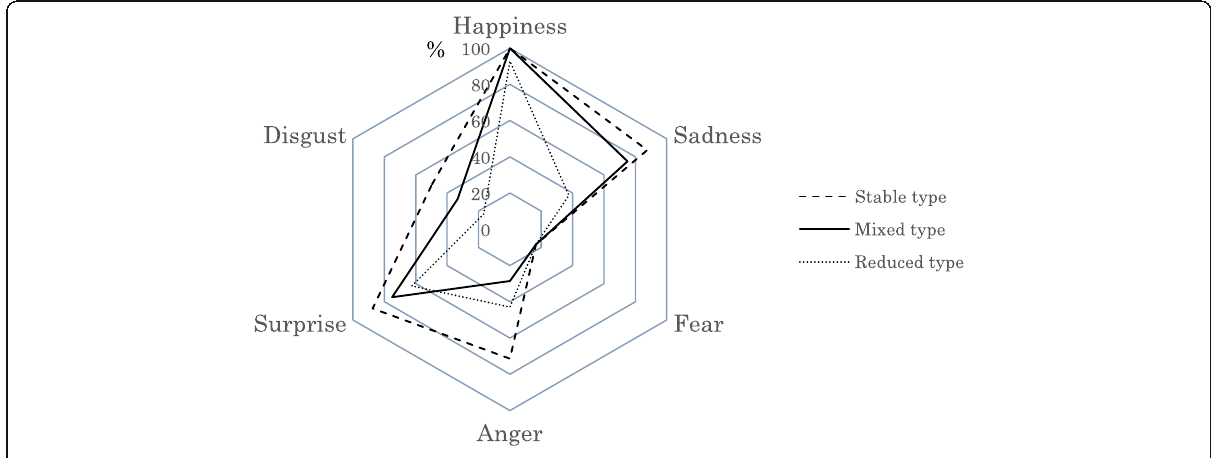
Fig. 1 Facial expression recognition accuracy rate by